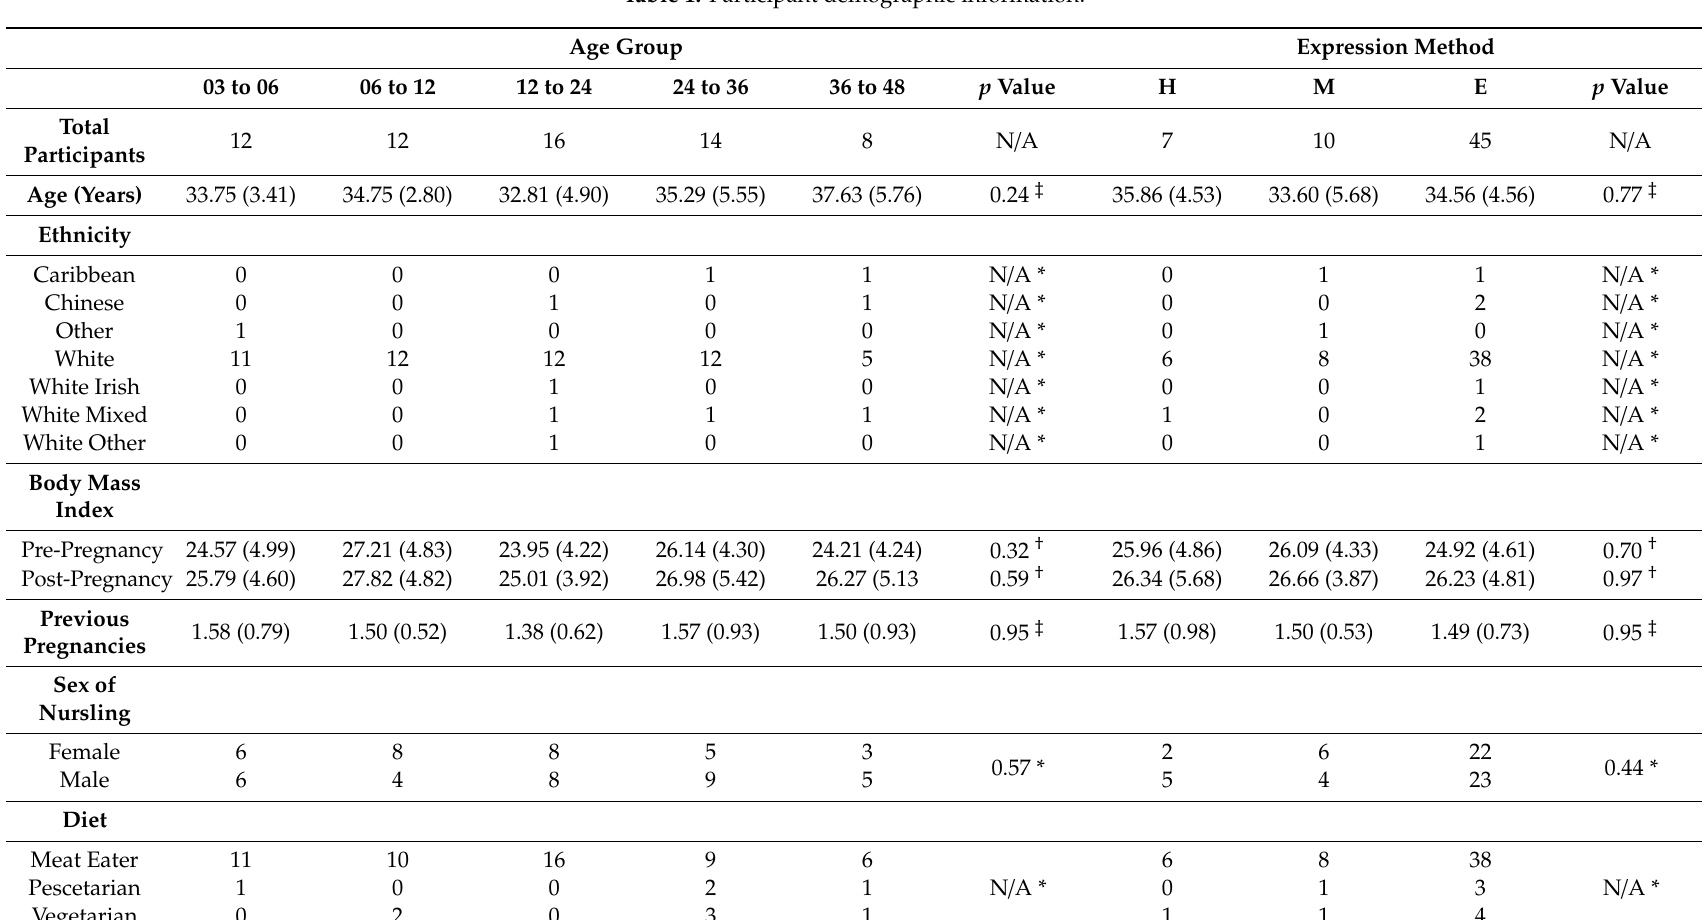
Table 1. Participant demographic